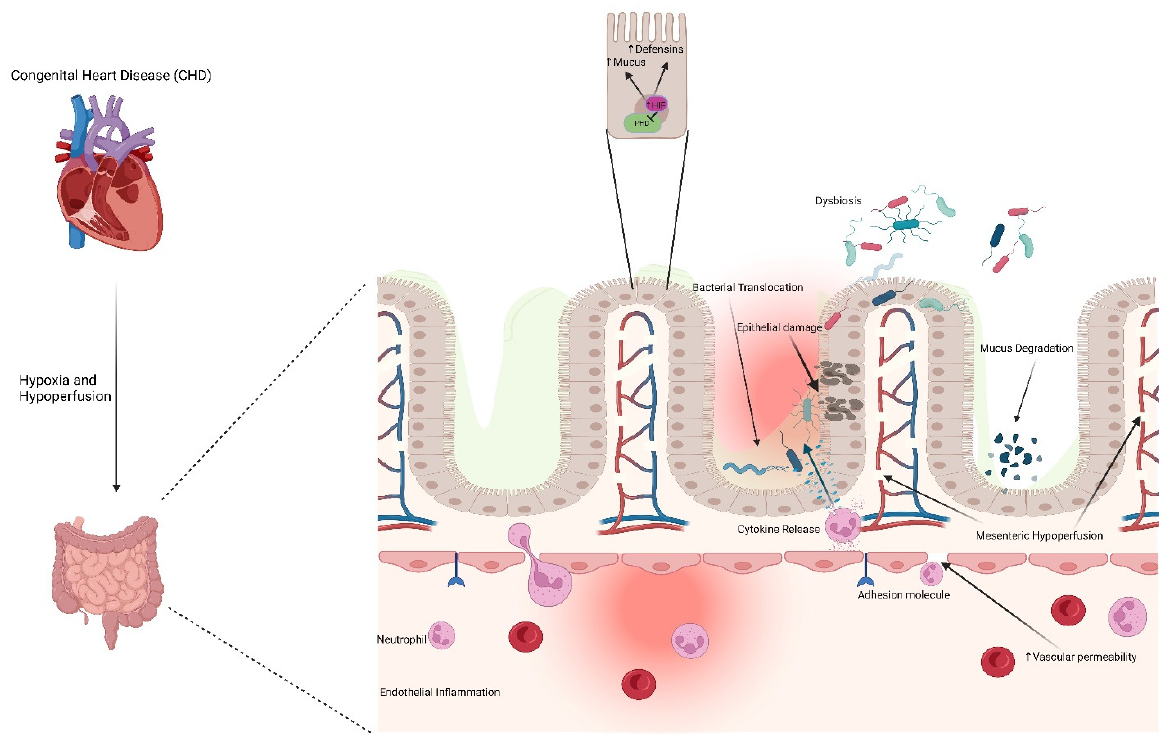
Figure 1. Speculated mechanisms contributing to cardiac NEC. Congenital heart disease induces mesenteric hypoperfusion and hypoxia in the gut, resulting in endothelial inflammation, vascular permeability, release of cytokines, epithelial damage, bacterial translocation, degradation of mucus, and dysbiosis. HIF: hypoxia inducible factor; PHD: prolyl hydroxylase domain; NEC: necrotizing enterocolitis. Created with Biorender.com (accessed on 6 July 2022).